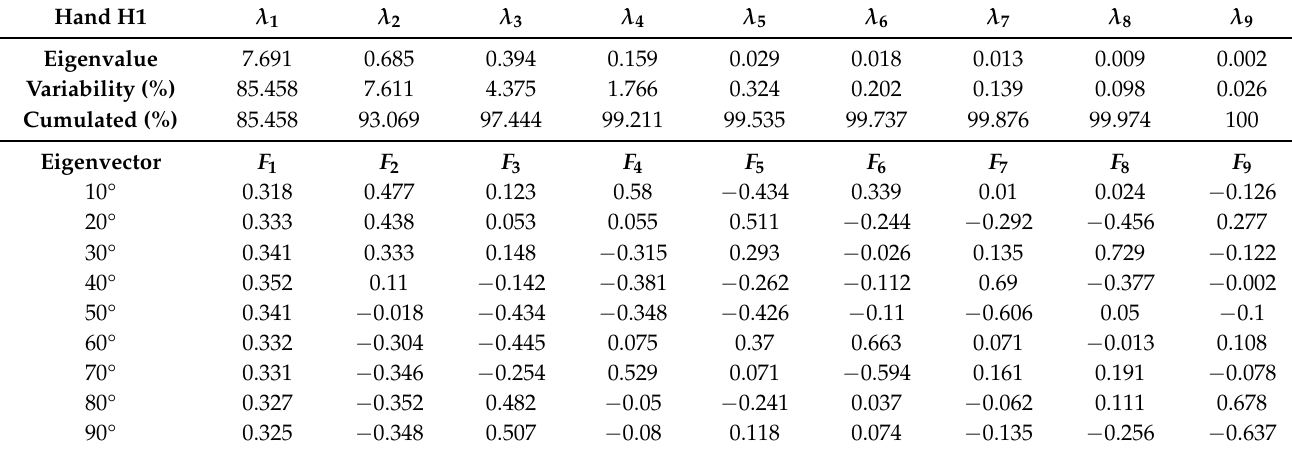
Table 3. PCA results for the H1 hand.